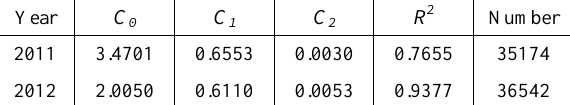
Table 2. Regression results of F18(2011, 2012) and F121999